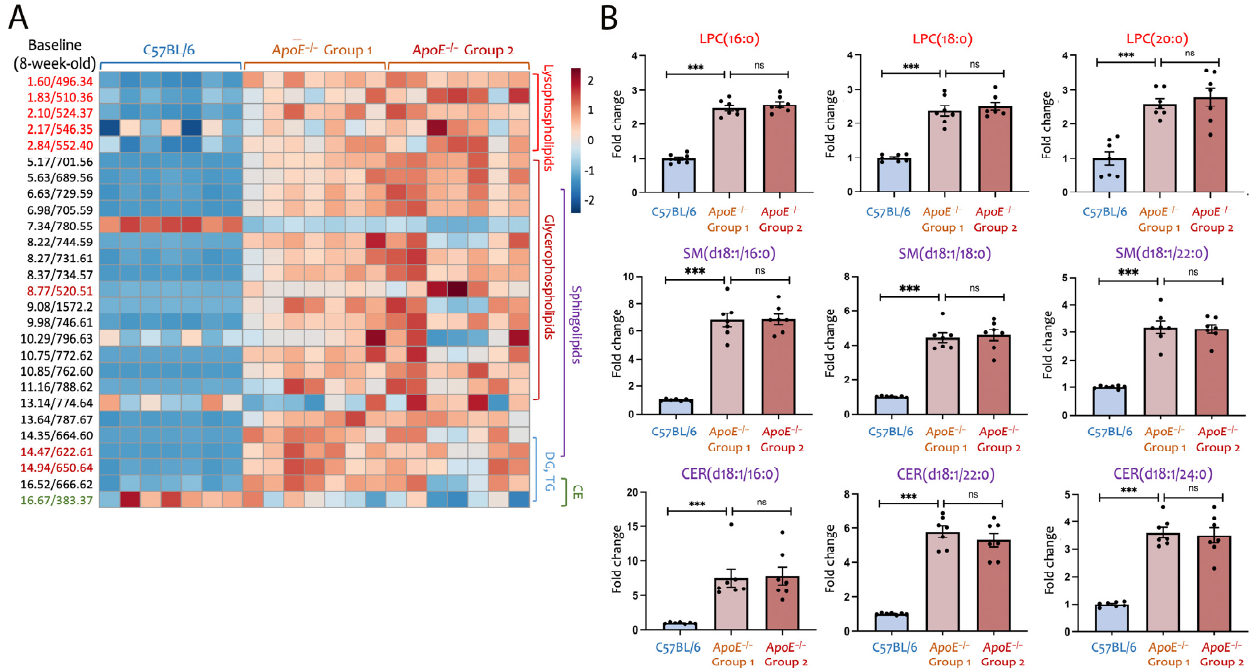
Figure 2. Altered lipid profile in the respective animal groups at eight weeks of age. We chose m/z signals with (1) higher abundance, (2) a fold change greater than 2, and (3) p values less than 0.001 to be the selecting markers of untargeted plasma lipidomic profiling of all the three groups of mice at the 8-week-old baseline. ( A ) A total of 27 markers were chosen to represent various lipid components between groups in a heatmap. By the exact mass and retention time, some of the 27 markers were identified. ( B ) LPC(16:0), LPC(18:0), LPC(20:0), SM(d18:1/16:0), SM(d18:1/18:0),